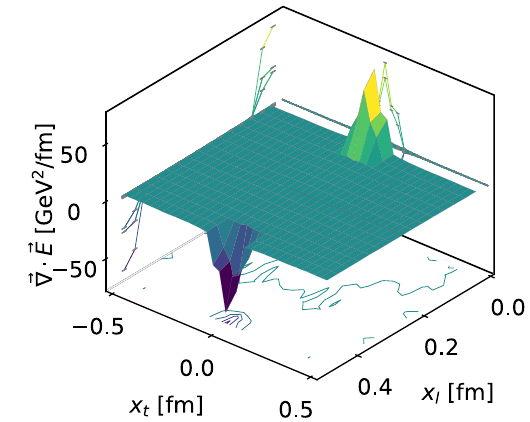
Fig. 6 Scaling of the divergence of full field at a transverse plane x l = d / 4 ≈ 0 . 128 fm Fig. 7 Divergence of the full field produced by a quark–antiquark pair